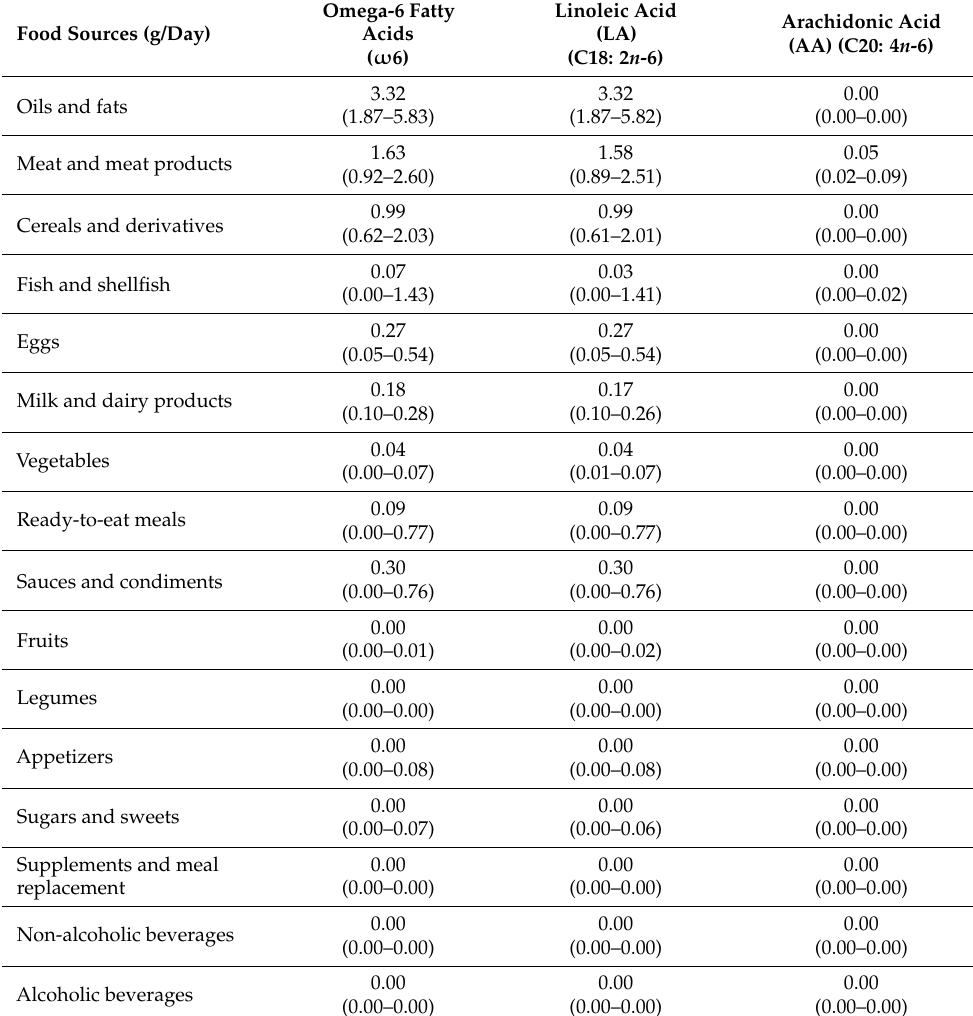
Table 17. Contribution of dietary food sources to omega-6 fatty acid intakes among the ANIBES Study